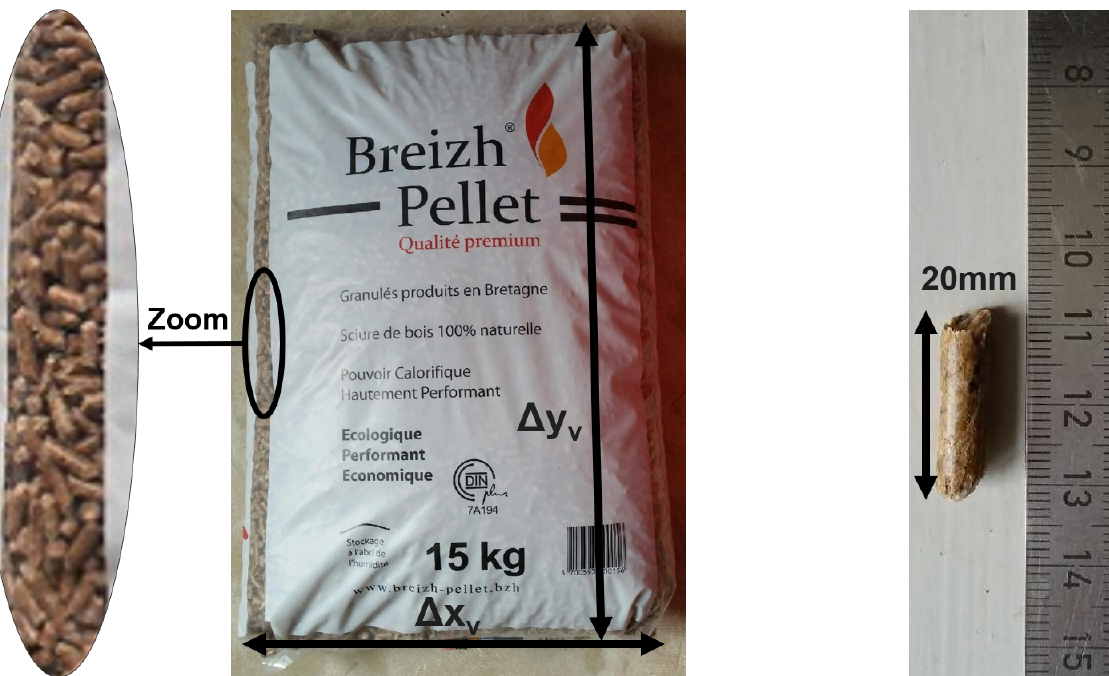
Figure 3. Bag of wood pellets used to simulate a volume and picture of pellet